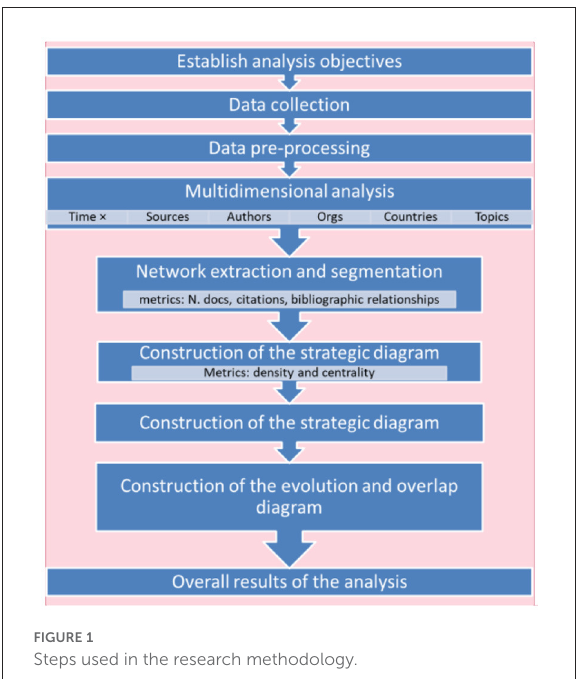
FIGURE1 Steps used in the research methodology.